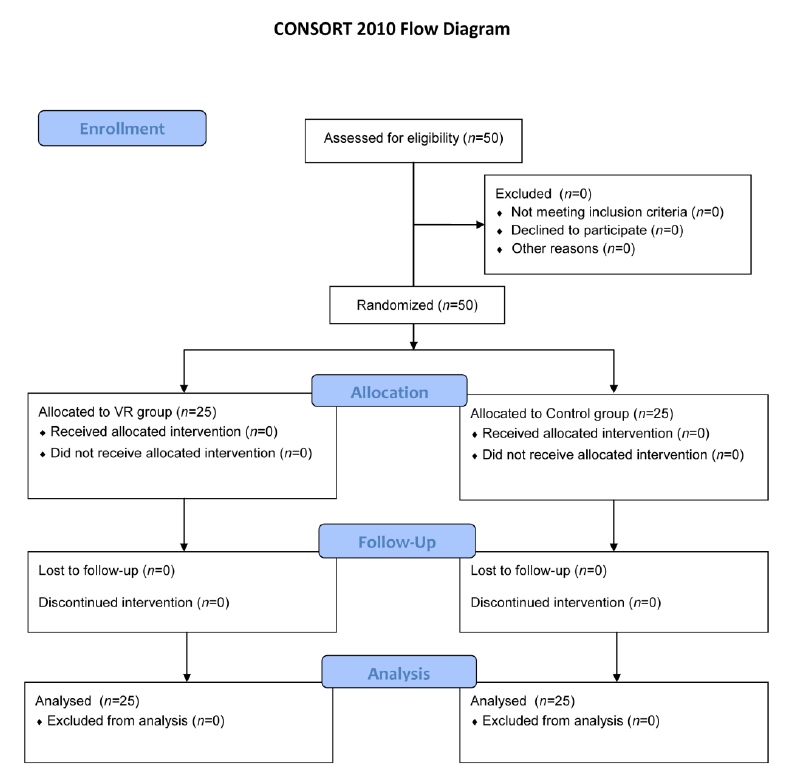
Figure 3. CONSORT flow diagram